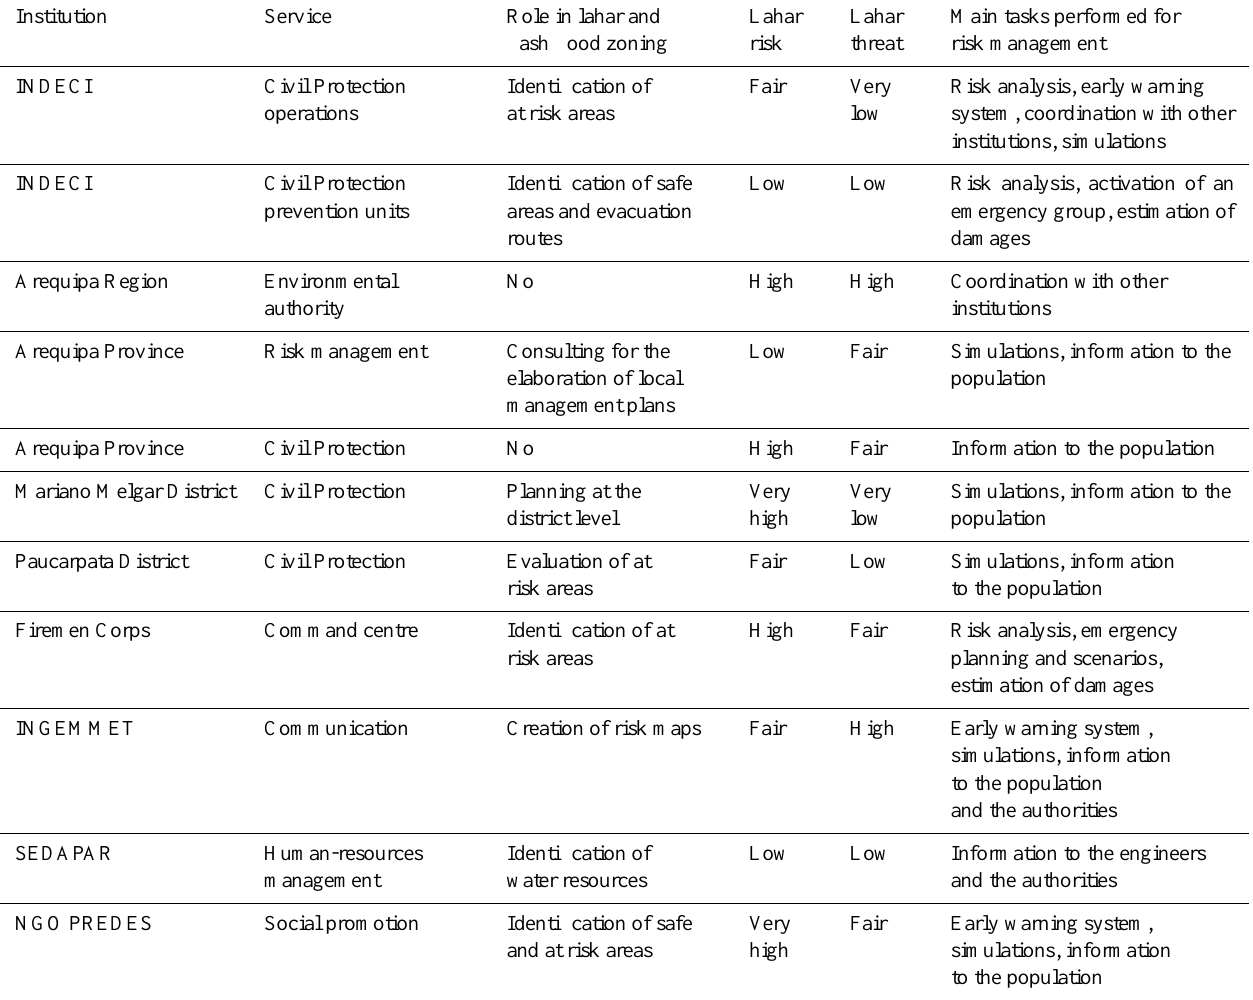
Table 2. Summary of interviews with institutes, civil authorities and agencies in charge of lahar- and flood-risk management. Each line of the table corresponds to a single interview with a risk manager who compared lahar risk with other risks posed by natural hazards (e.g. volcanic eruptions, earthquakes, landslides, drought and climate